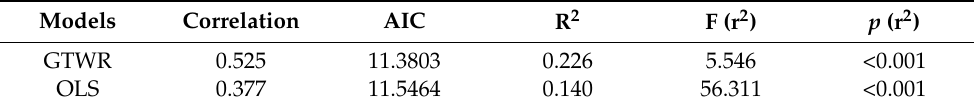
Table 4. Comparison of model diagnostic